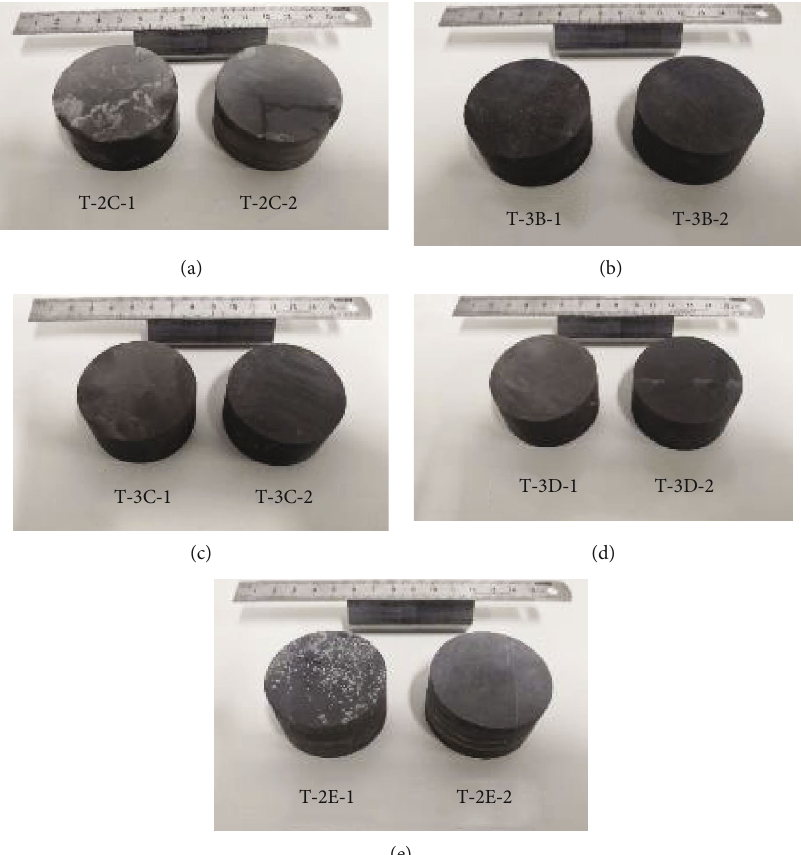
Figure 2: Test specimen for thermal conductivity of clay rock: (a) Sample No. T-2C-1 and T-2C-2; (b) Sample No. T-3B-1 and T-3B-2; (c) Sample No. T-3C-1 and T-3C-2; (d) Sample No. T-3D-1 and T-3D-2; (e) Sample No. T-2E-1 and